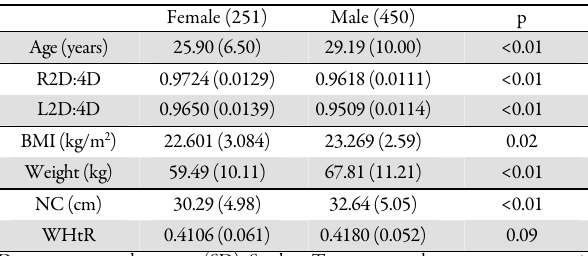
Table 1. Characteristics of the study population